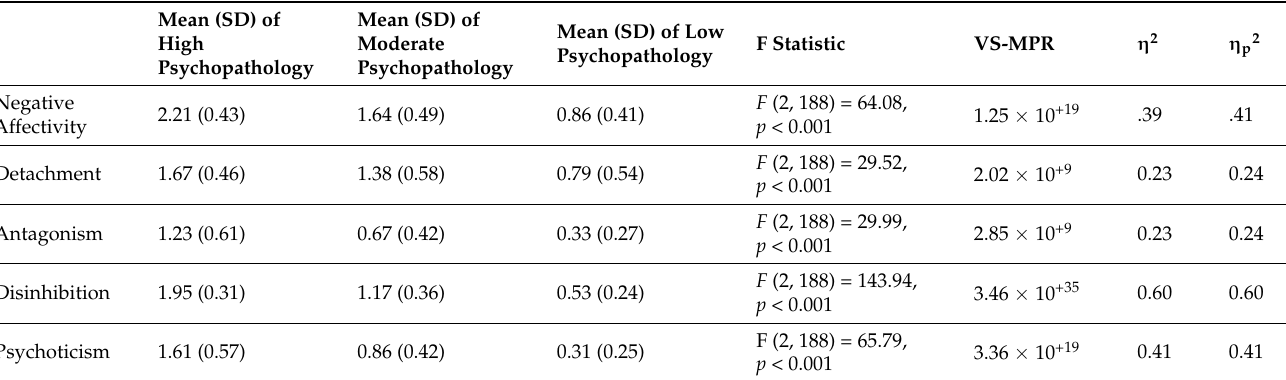
Table A2. Means, Standard Deviations, ANCOVA F statistic, Vovk-Sellke Maximum p-Ratio, and eta squared of AMPD-Only Profiles.